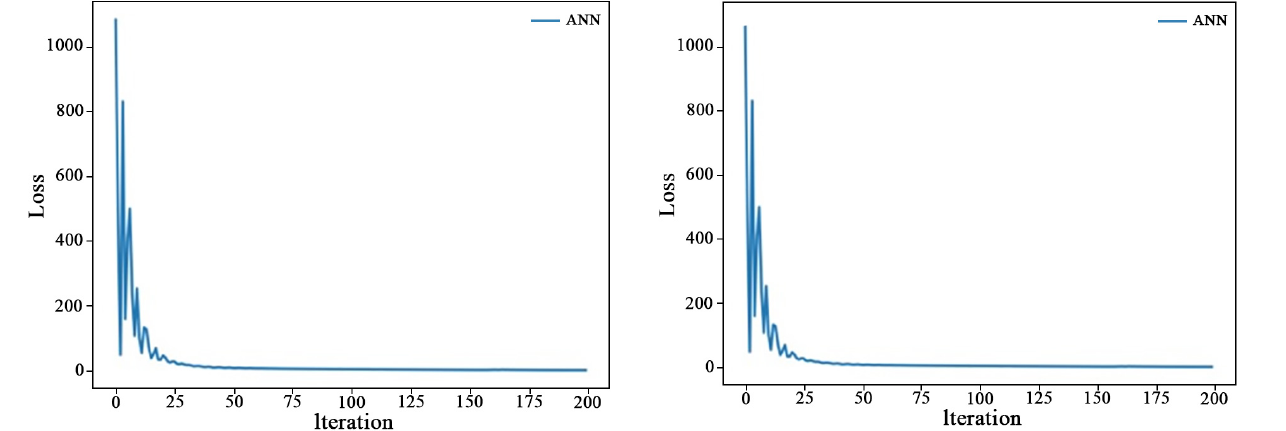
Fig. 10. When the network iterates 200 times.